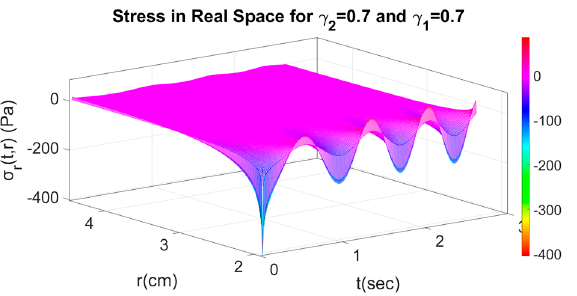
Figure 18. Distribution of the radial stress σ r ( t , r ) in the initial space with space (porosity) fractional order γ 1 = 0.7 and time fractional order γ 2 = 0.7.